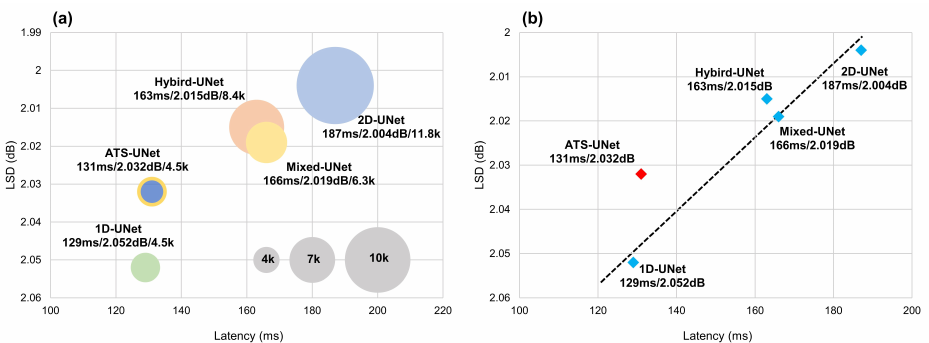
Figure 7. ( a ) The trade-off between on-chip latency and audio super resolution performance measured by LSD. The number of parameters is represented by circle size. ( b ) Without ATSM, there is a linear relationship between latency and LSD. ATS-UNet is on the upper left of the dotted line, thereby, proving its superiority.